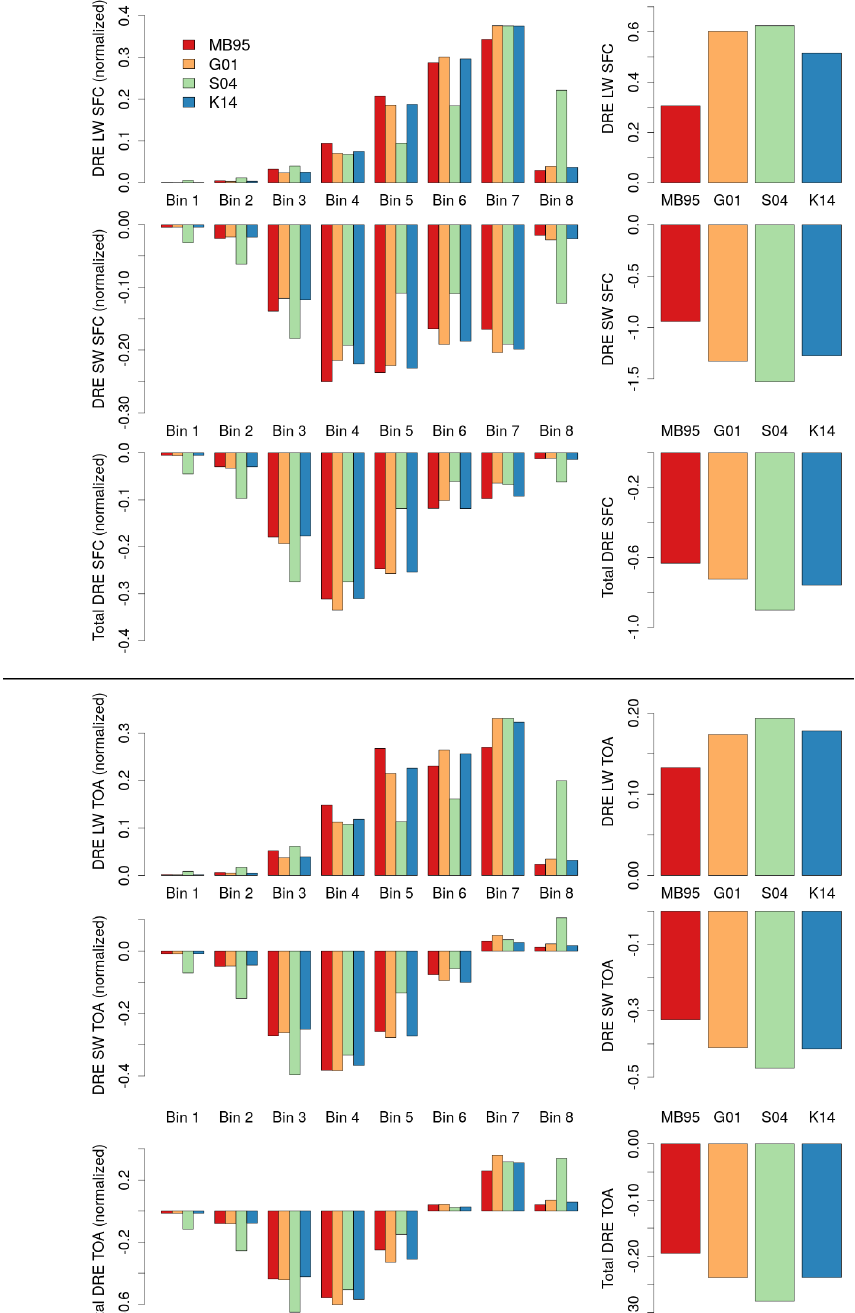
Figure 11. Global averages of MONARCH-derived DRE [Wm − 2 ] for each run at the SFC and TOA for shortwave and longwave radiation and the total (shortwave and longwave). Shown are the relative contributions per bin, normalized with the absolute value of the DRE for all bins (left) and the DRE for all particle sizes (right). The diameter ranges and effective radii of each bin are given in, respectively, Sect. 3 and Table 6. The DRE results are also given in Appendix